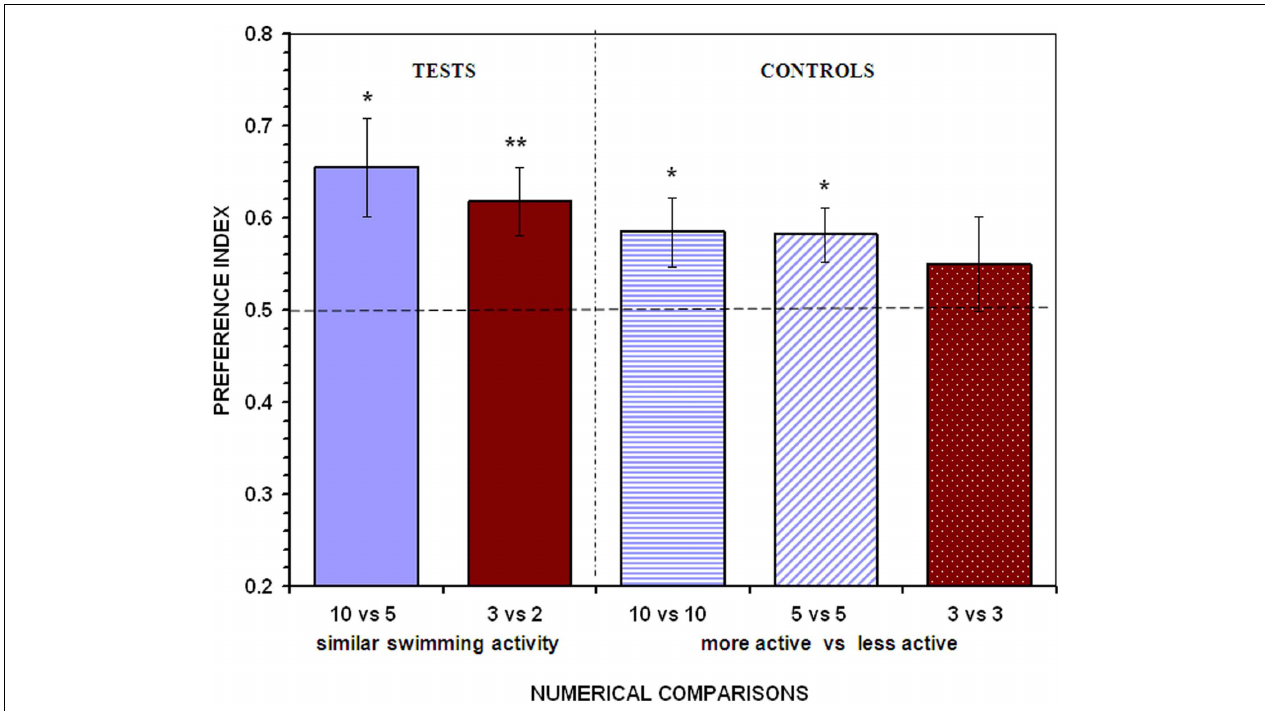
small sectors (i.e., stationary) while the other was allowed to swim (i.e., active). Proportion of time ( preference index ) spent by test fish in the 10cm preference zone close to stimulus fish (mean ± SEM) is shown.Values above 0.5 indicate a preference for the more numerous shoal of stimulus fish or a preference for the active shoal when the stimulus shoals are of the same numerical size. Significant departure from the null hypothesis of no preference is indicated by asterisks: ** P < 0.01, * P <